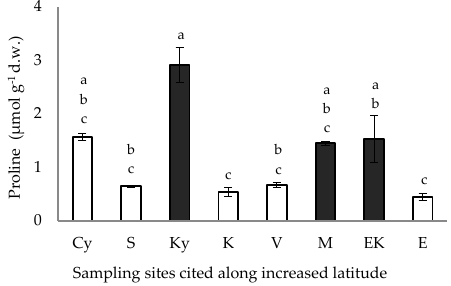
Figure 6. Free proline accumulation in fruit pericarp of C. spinosa harvested from inland (closed bars) and coastal habitats (open bars), cited along increased latitudinal gradient. The values are means ± standard deviation; significant difference ( p < 0.05) of mean values was detected using Kruskall–Wallis’ test and is marked using lowercase letters, according to post hoc analysis.